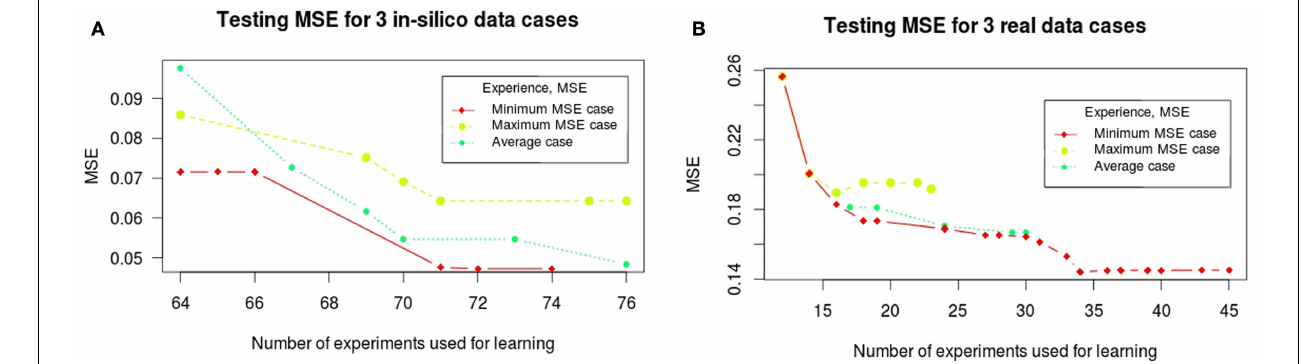
the number of experiments (optimal signaling perturbations and measurements associated) used for learning at each iteration. The Y -axis shows the testing MSE obtained at each iteration; it represents the quality of the learned models with respect to the full experimental dataset at each